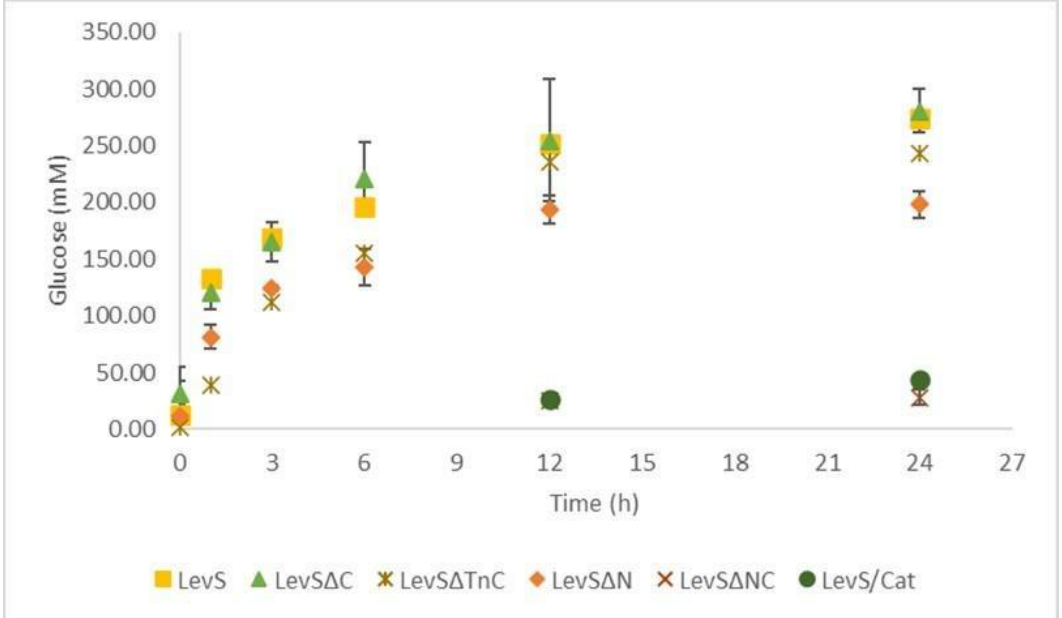
Figure 2. Effect of the additional domains of LevS on the enzymatic reaction. Reaction progress on 100 g/L sucrose and 1 U/mL enzyme for LevS and truncated versions.